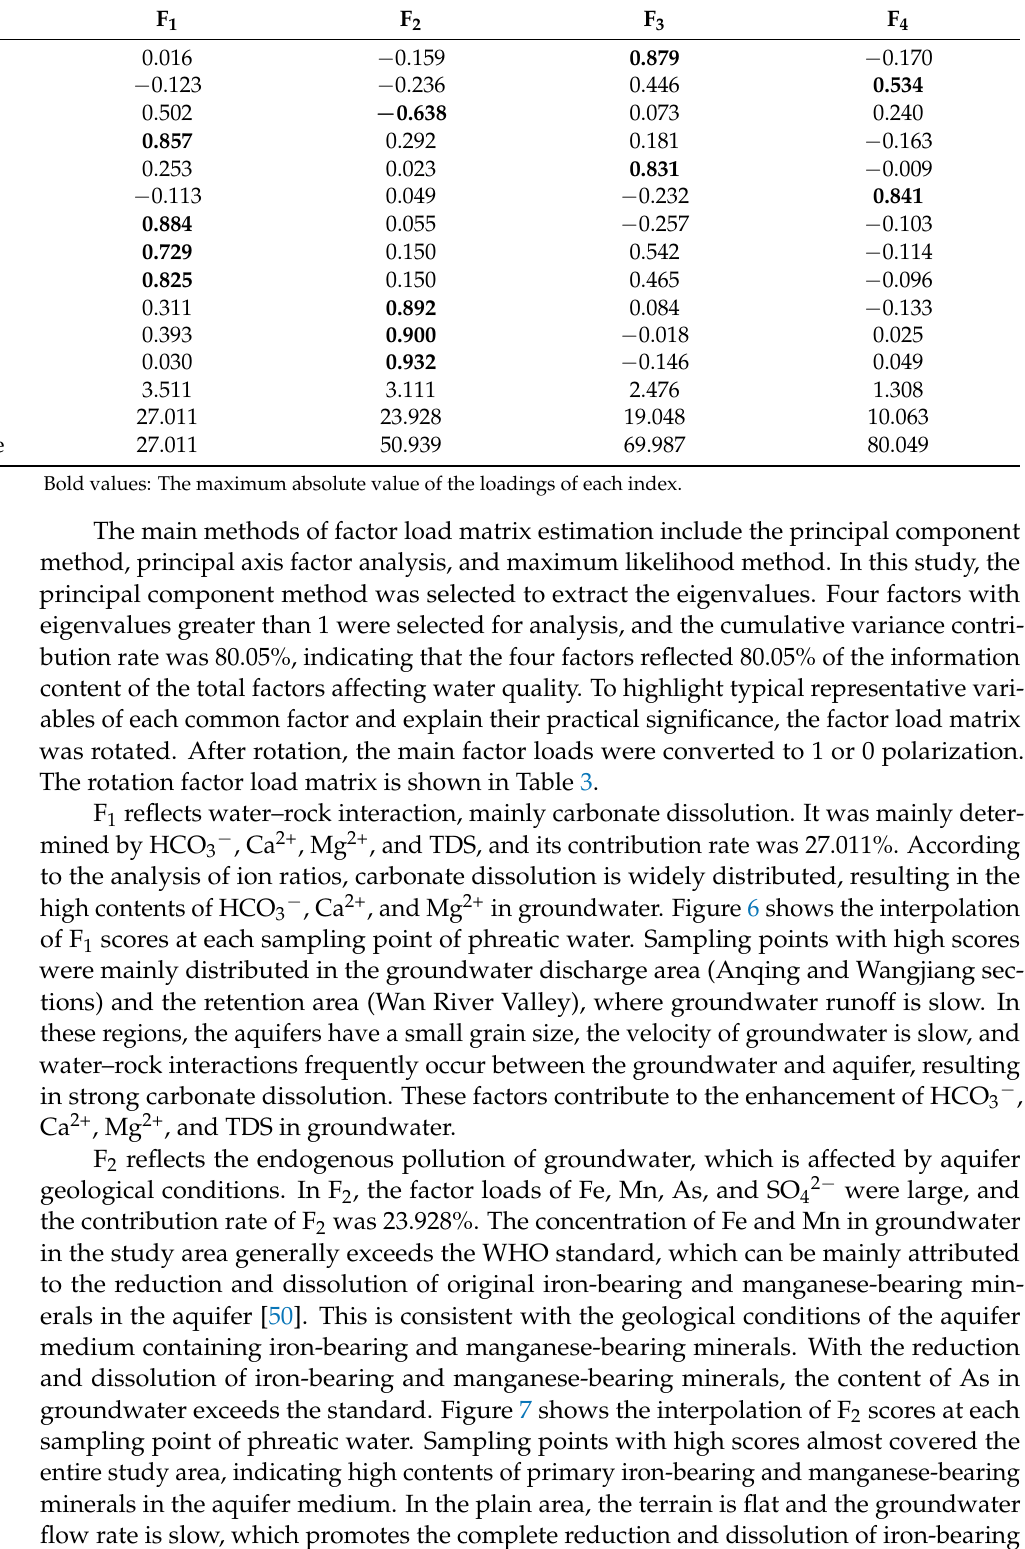
Table 3. Loading for varimax rotated factor matrix of a four-factor model explaining 80.05% of the total variance.